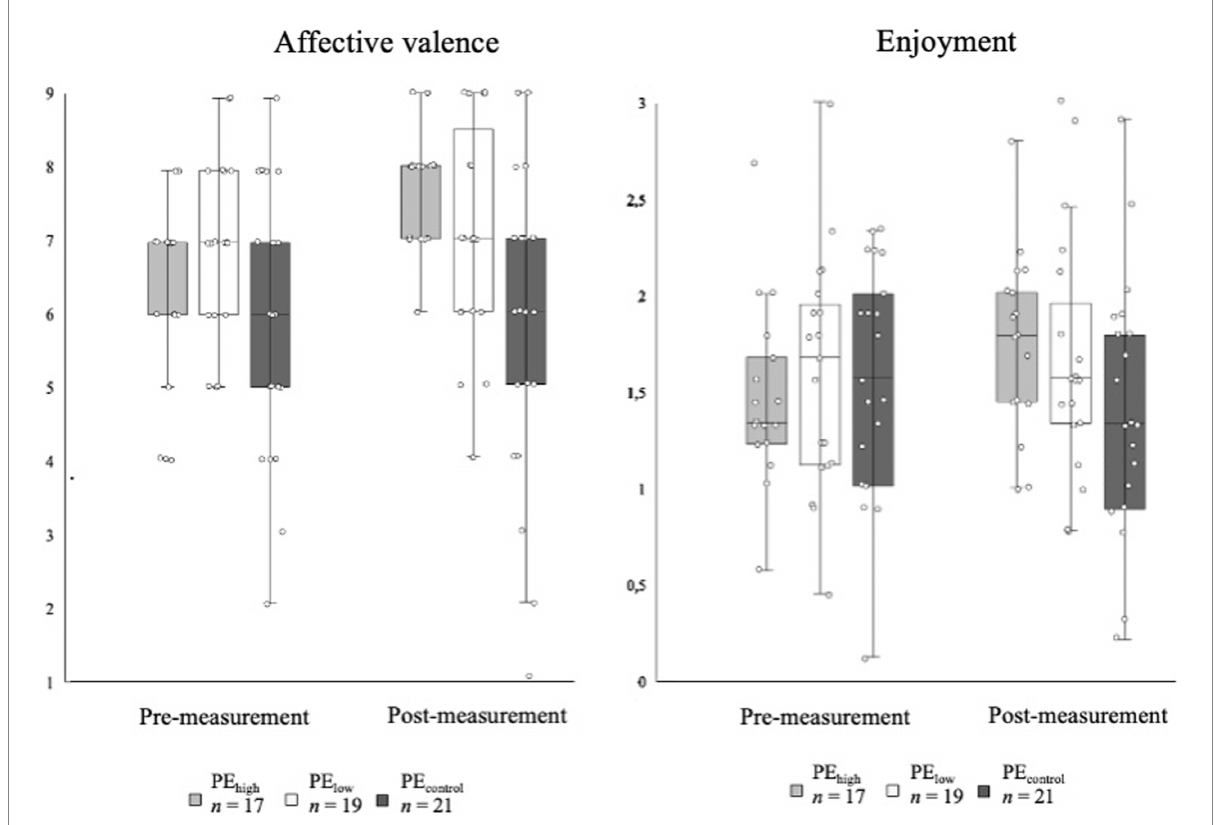
FIGURE 3 Outcome variables: Boxplot charts show distribution of data points at pre- and post-measurement for affective valence and enjoyment in high (PE high ), low autonomy-supportive (PE low ), and controlling PE classes (PE control ). Single data points